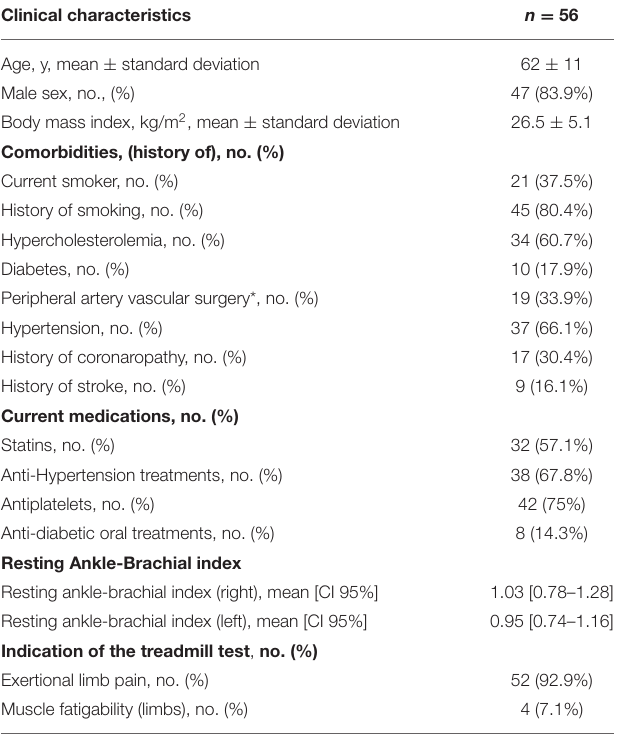
TABLE 1 | Population characteristics. Clinical characteristics